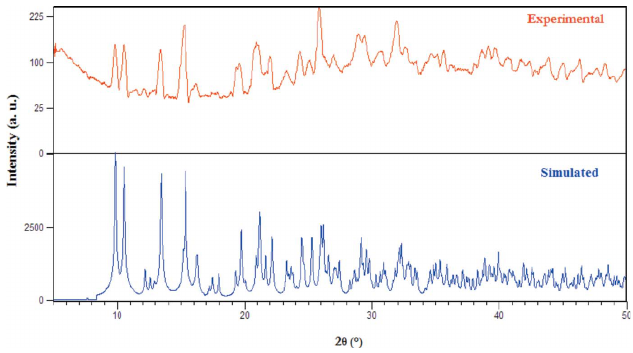
Figure 2 Experimental and simulated powder XRD patterns of (I).